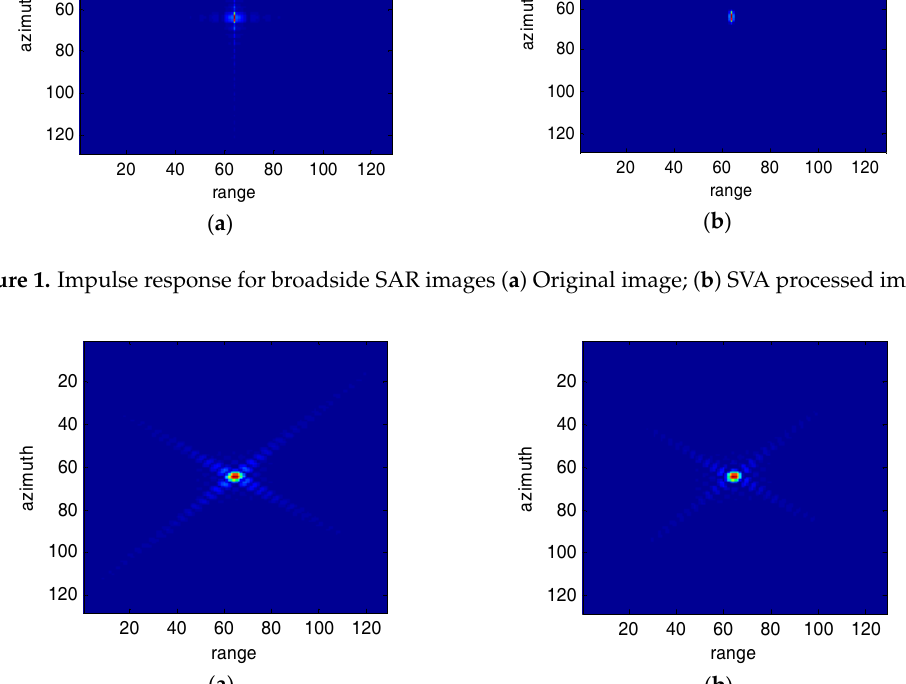
Figure 2. Impulse response for Squint SAR images (40°). ( a ) Original image; ( b ) SVA processed image.